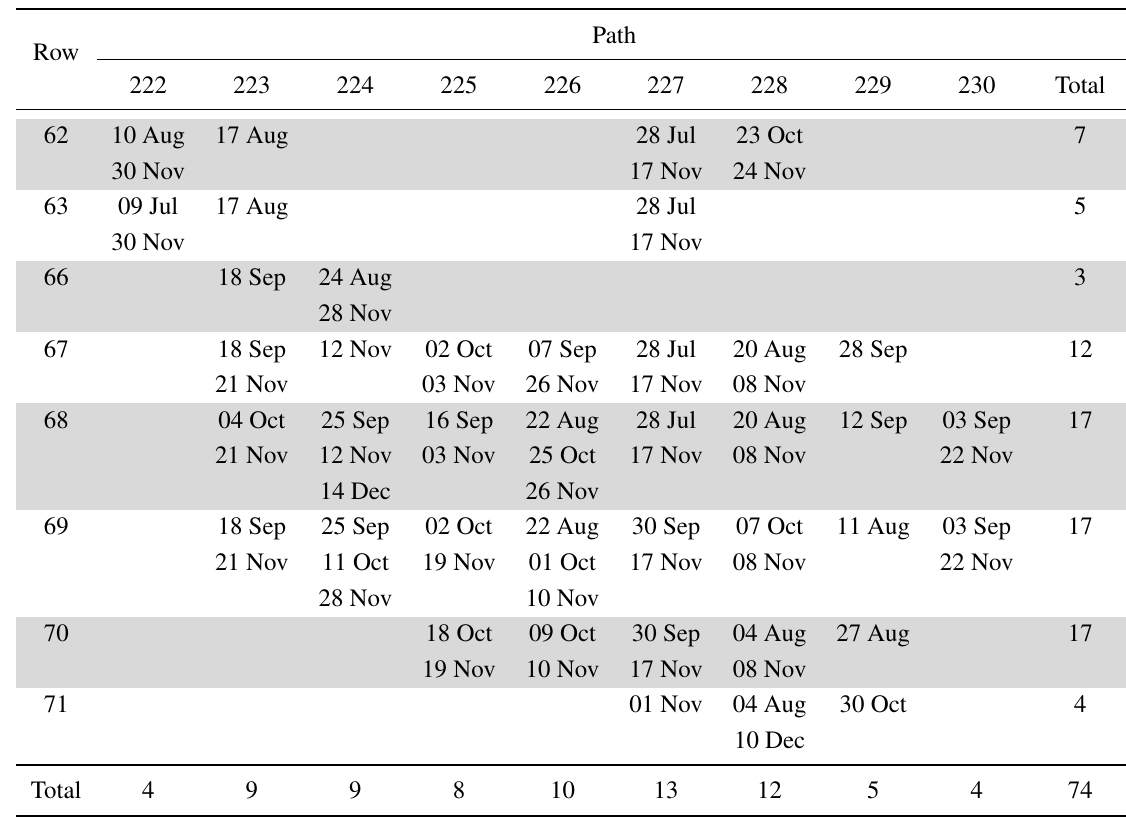
Table 2. Acquisition dates of the TM/Landsat images in 2009 used to refine the selection of polygons with annual